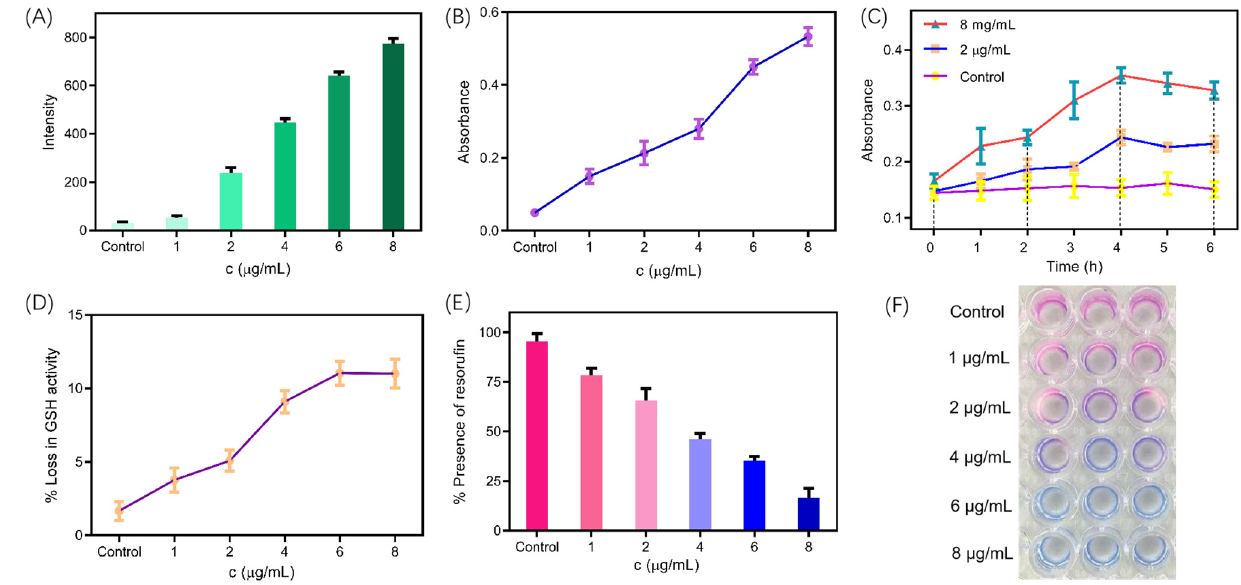
Figure 8. Measurement of intracellular oxidative stress in C. tropicalis treated with thioether benzimidazole 7f . ( A ) Intracellular ROS production ( λ em = 528 nm); ( B ) Malondialdehyde ( λ abs = 535 nm); ( C ) Reactive nitrogen intermediates ( λ abs = 540 nm); ( D ) Loss in GSH activity ( λ abs = 412 nm); ( E ) Presence of resorufin ( λ em = 590 nm); ( F ) The picture of the transformation from reduction state (resorufin) to oxidation state (resazurin).